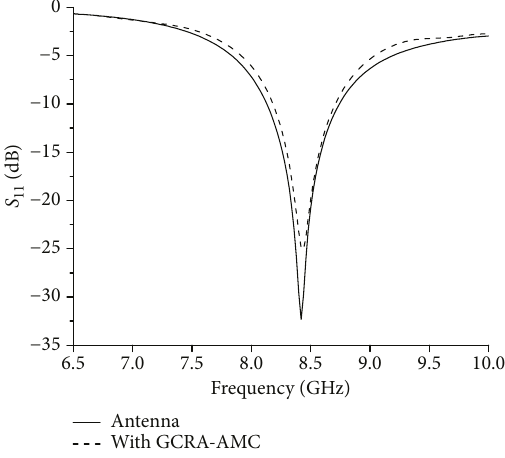
Figure 5: The monostatic RCS of the antenna.